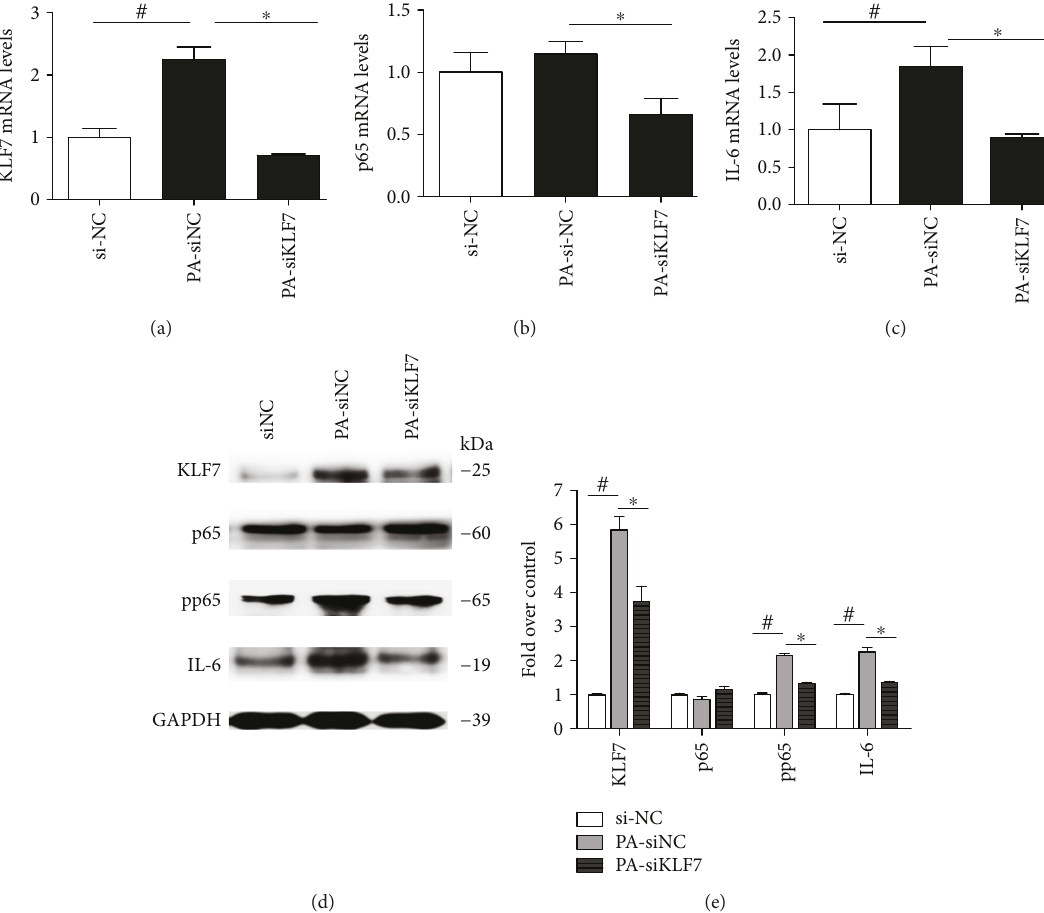
Figure 5: The mRNA (a – c) and protein (d, e) expression levels of in fl ammatory cytokines in adipocytes were detected by using PA to stimulate adipocytes and downregulate the KLF7 expression for 48 h. Grayscale scanning of proteins (e) (siNC: negative control of siRNA, PA-siNC: PA and negative control of siRNA, PA-siKLF7: PA and siKLF7). The mRNA data for each group is derived from three replicates of experimental data. One-way ANOVA (a – c, e), PA-siNC: PA-siKLF7, ∗ P < 0 05 ; siNC: PA-siNC, # P < 0 05 . The di ff erence was statistically signi fi